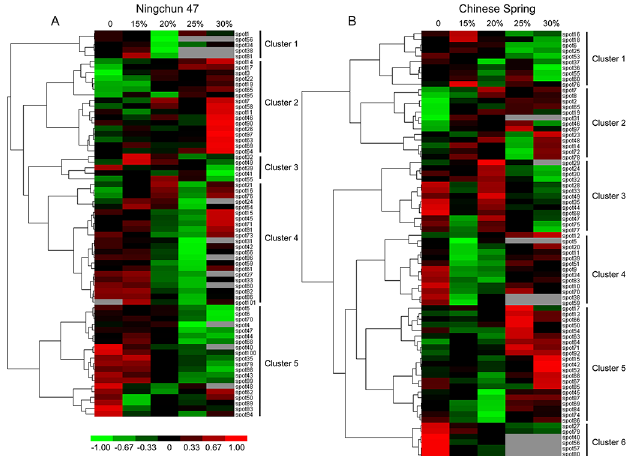
Fig 5. Hierarchical cluster analysis of DAP spots in NC47 and CS. Red colour indicates a positive abundance in protein spots; green colour denotes a negative abundance in protein spots. (A) Cluster analysis of 69 differentially accumulated proteins in NC47. (B) Cluster analysis of 77 differentially accumulated proteins in CS. 0, 15%, 20%, 25% and 30% represent the PEG6000 concentration